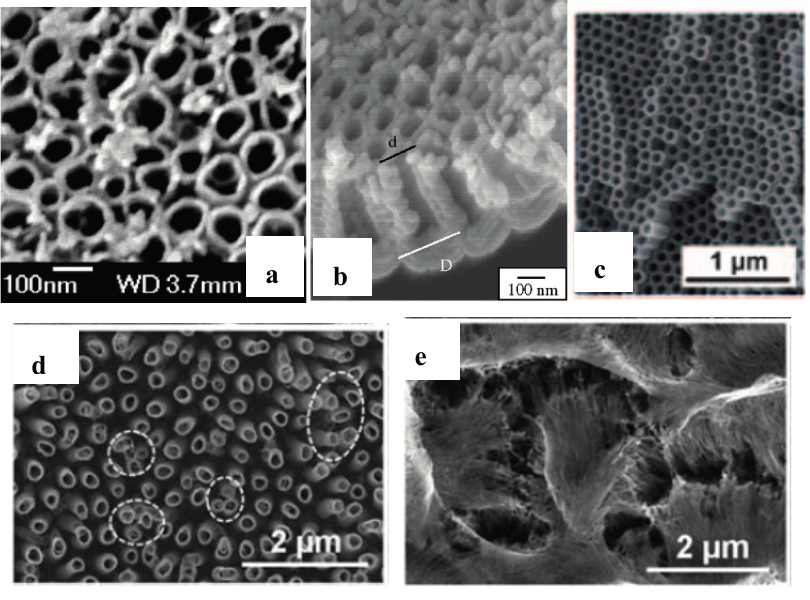
Figure 3. Scanning electron microscopy images: ( a – c ) highly ordered NTT viewed from various angles; ( d ) bundled TNT within the white circles; ( e ) TNT with grass-like aspect (“nanograss”) due to collapsing of tube walls. Reproduced with permission from references [1] (a,b) and [5]